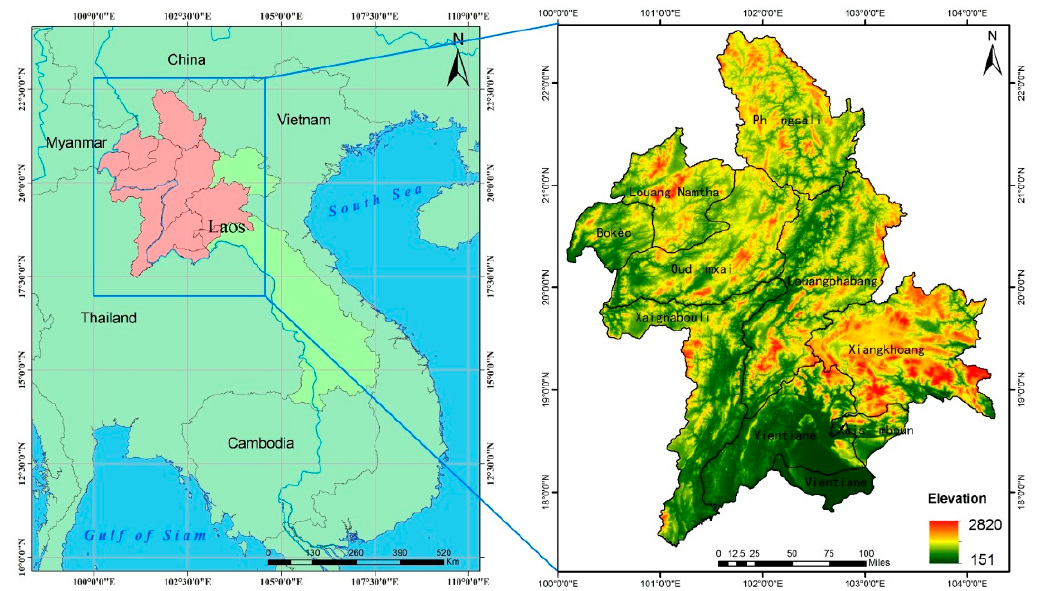
Figure 1. Location and topographic map of the study area.